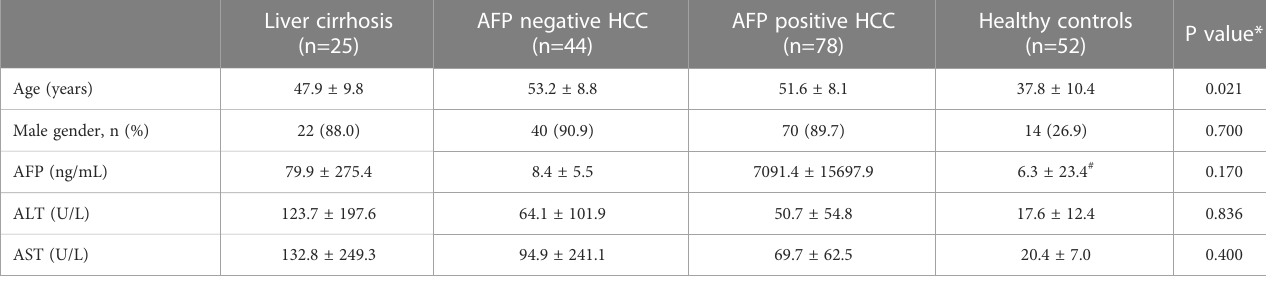
TABLE 1 Baseline characteristics of patients with liver